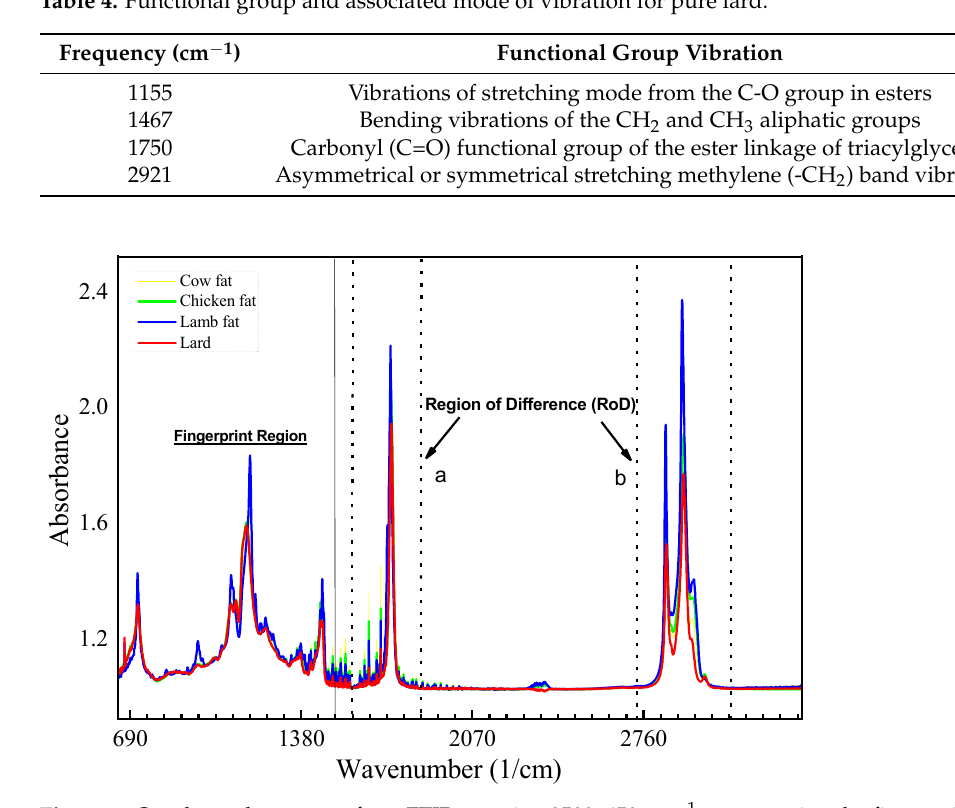
Figure 2. Overlapped spectrum from FTIR covering 3500–650 cm − 1 , representing the fingerprint and functional group regions for pure samples of beef, lamb, lard, and chicken, with identification of potential regions of difference (RoD).